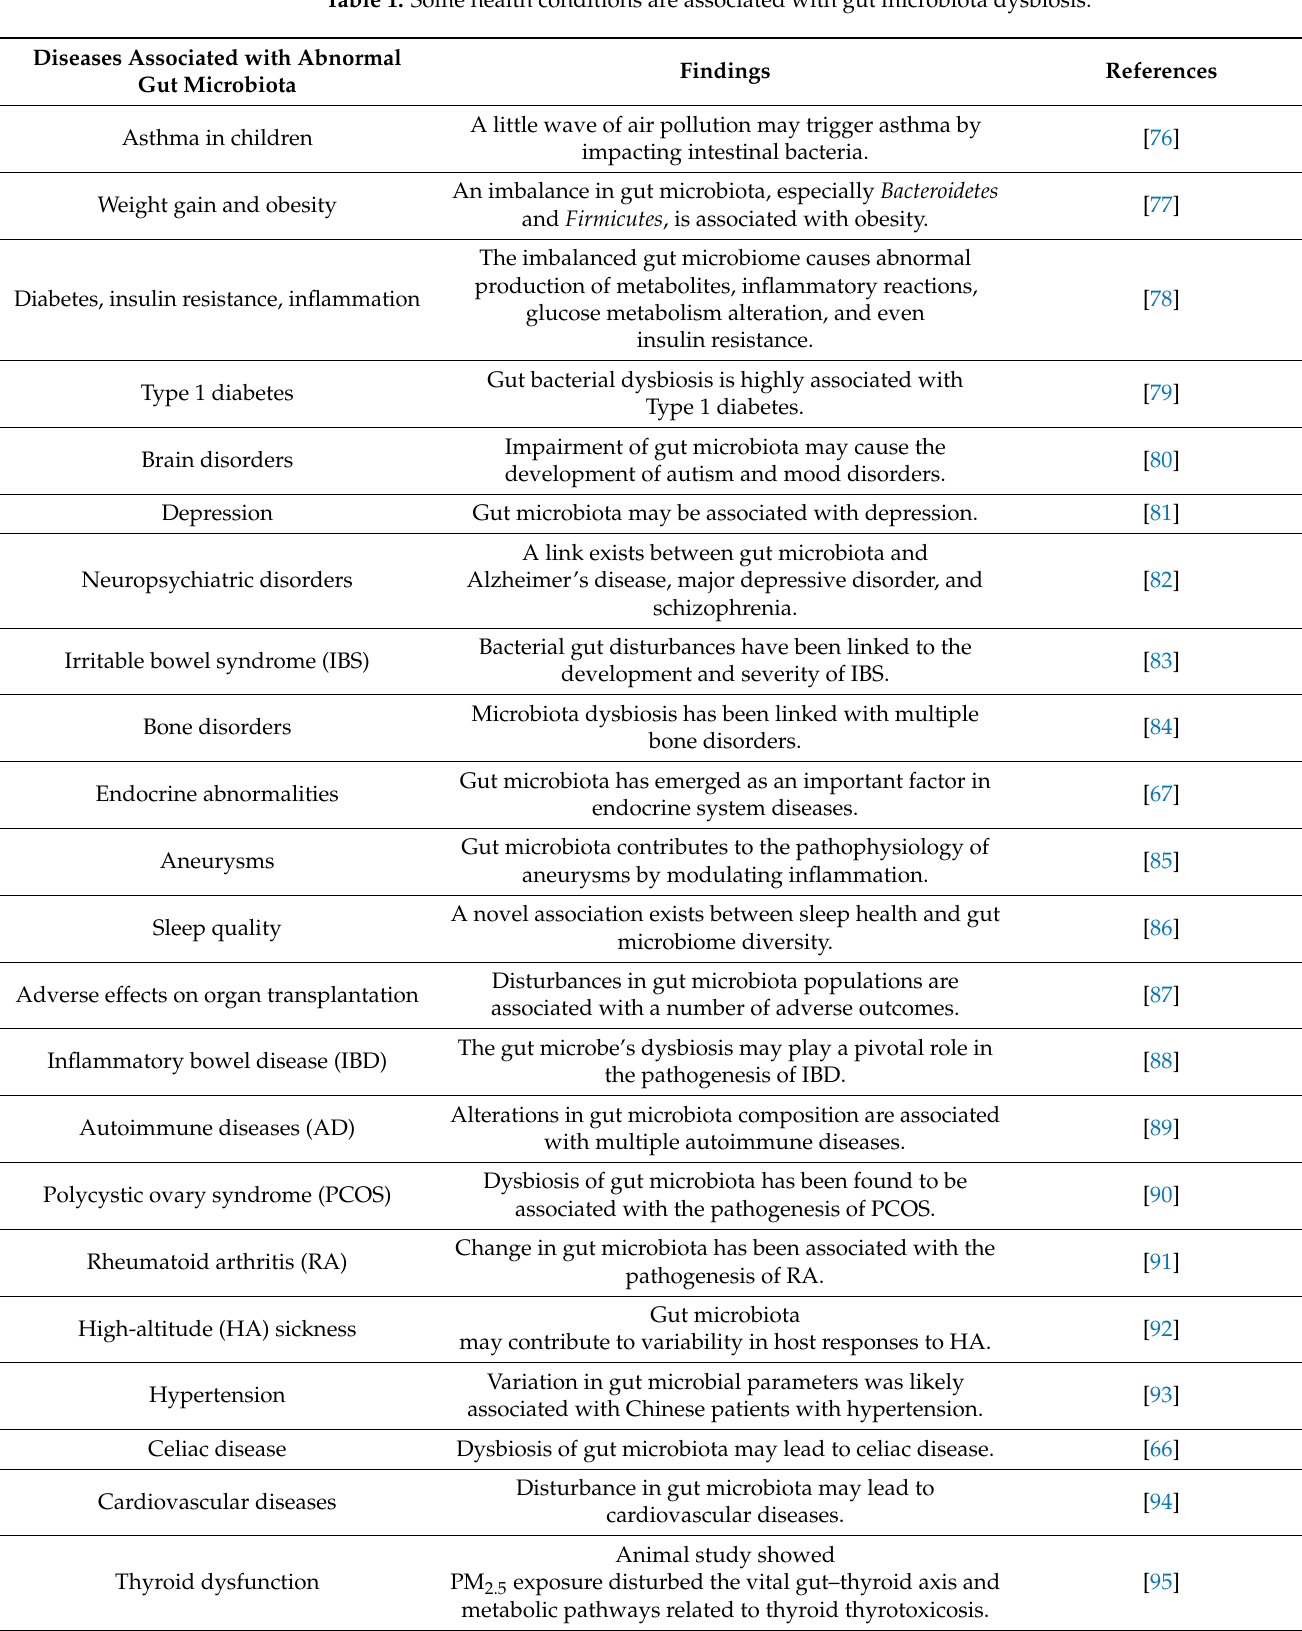
Table 1. Some health conditions are associated with gut microbiota